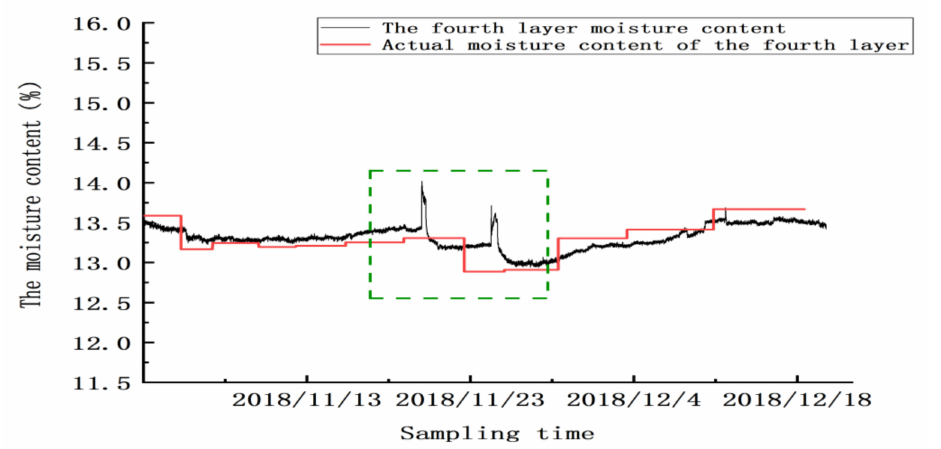
Figure 25. The moisture values of the grain in the fourth